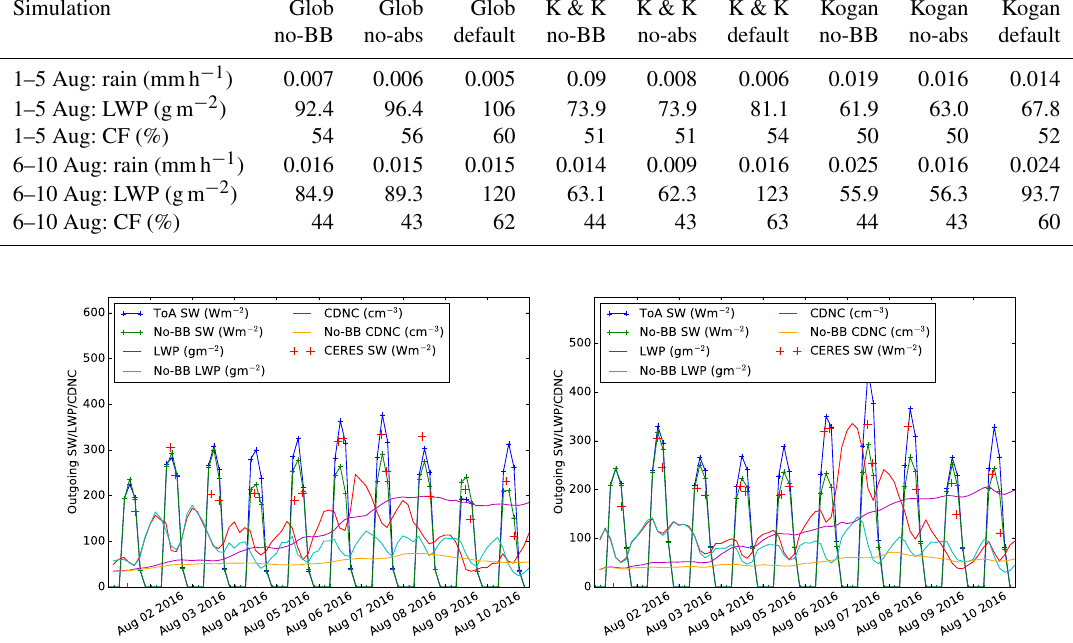
Table 2. Selected mean rain rates, liquid water paths and fractional cloud cover over the clean and polluted periods of the simulation. The values tabulated are for the global model and then for the regional model with the alternative parameterisations of autoconversion and accretion from (Kogan, 2013) and from (Khairoutdinov and Kogan, 2000) (labelled K&K). We present simulations with and without biomass burning emissions (“BB” vs. “no-BB”), and without aerosol absorption (“no-abs”) for both microphysical parameterisations. Simulation Glob